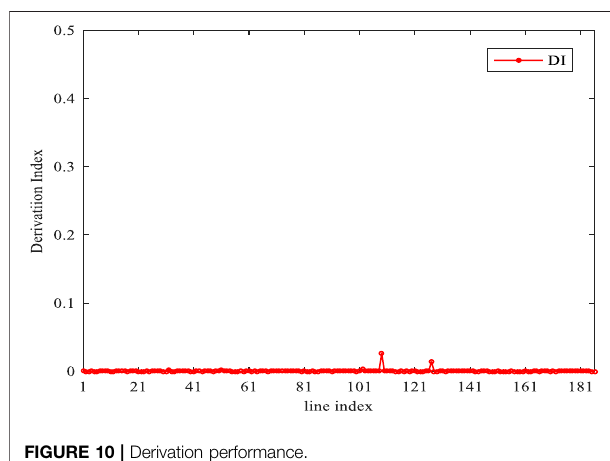
FIGURE 10 | Derivation performance.